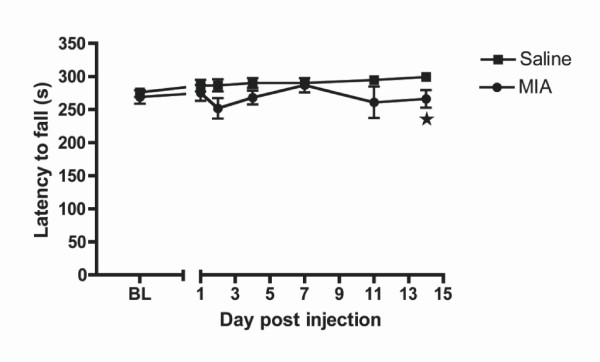
Motor coordination of MIA-injected mice. Latency to fall from the rotarod is expressed as mean ± S.E.M. Baseline (BL) measurements were measured 2–4 days before injection and expressed as a single mean value. * p < 0.05 compared with saline control animals (n = 10).